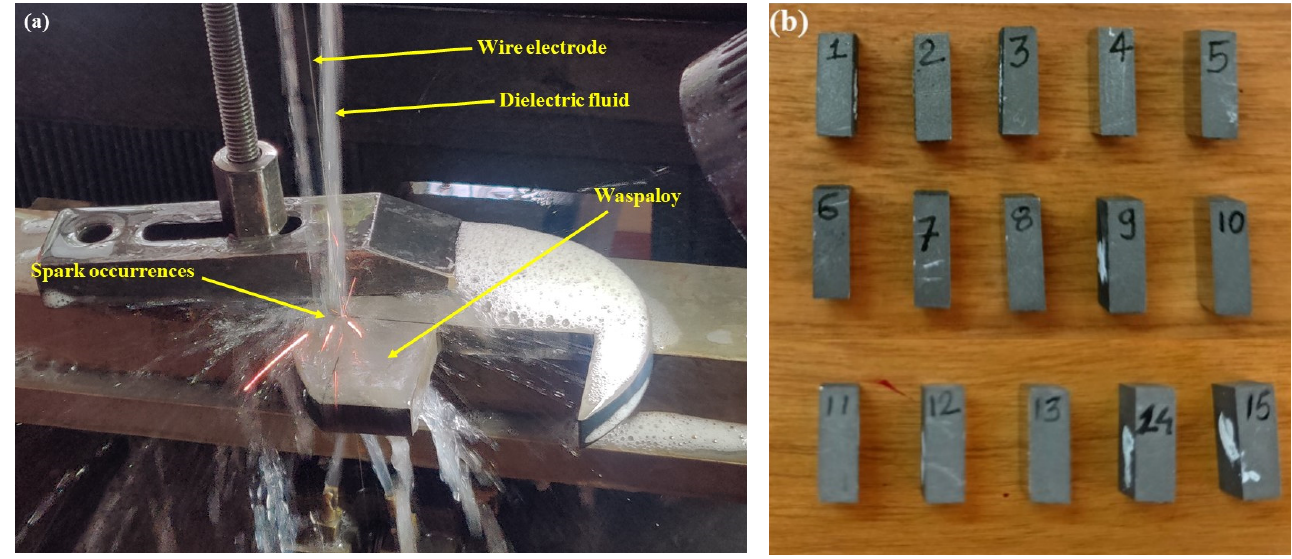
Figure 1. ( a ) Experimental setup of WEDM process ( b ) cut specimens as per BBD approach. Table 2. WEDM input variables. Process